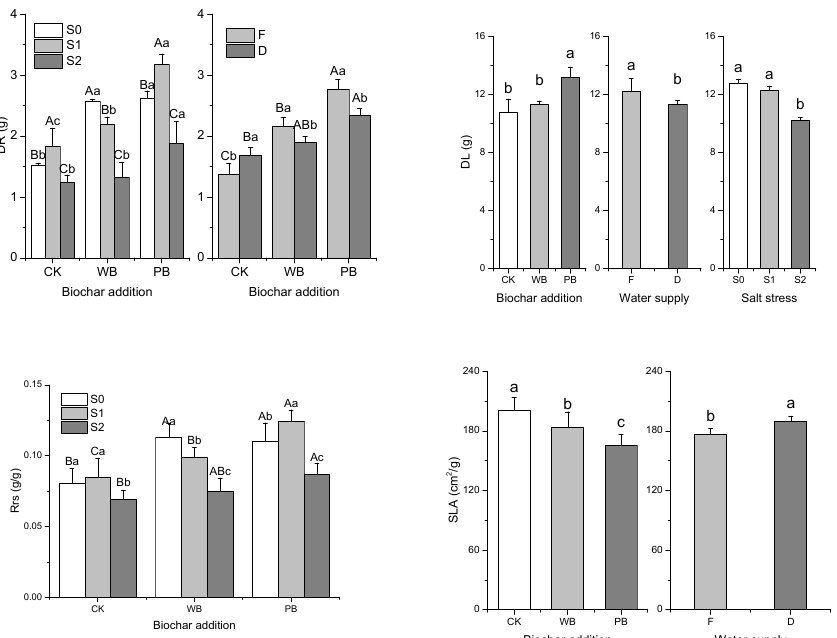
Figure 2. Plant height (H), dry mass accumulation (DM), dry root mass (DR), dry leaf mass (DL), ratio of root and shoot (Rrs), and specific leaf area (SLA) as affected by biochar addition (B), drought stress (W), and salt stress (S). The treatments are biochar type (no biochar control group, CK; wood biochar treatment, WB; poultry biochar, PB), water supply (F and D), and salt condition (S0, S1, and S2). Different uppercase letters indicate significant differences at the 0.05 level among CK, WB, and PB treatments. Different lowercase letters indicate significant differences at the 0.05 level within groups.